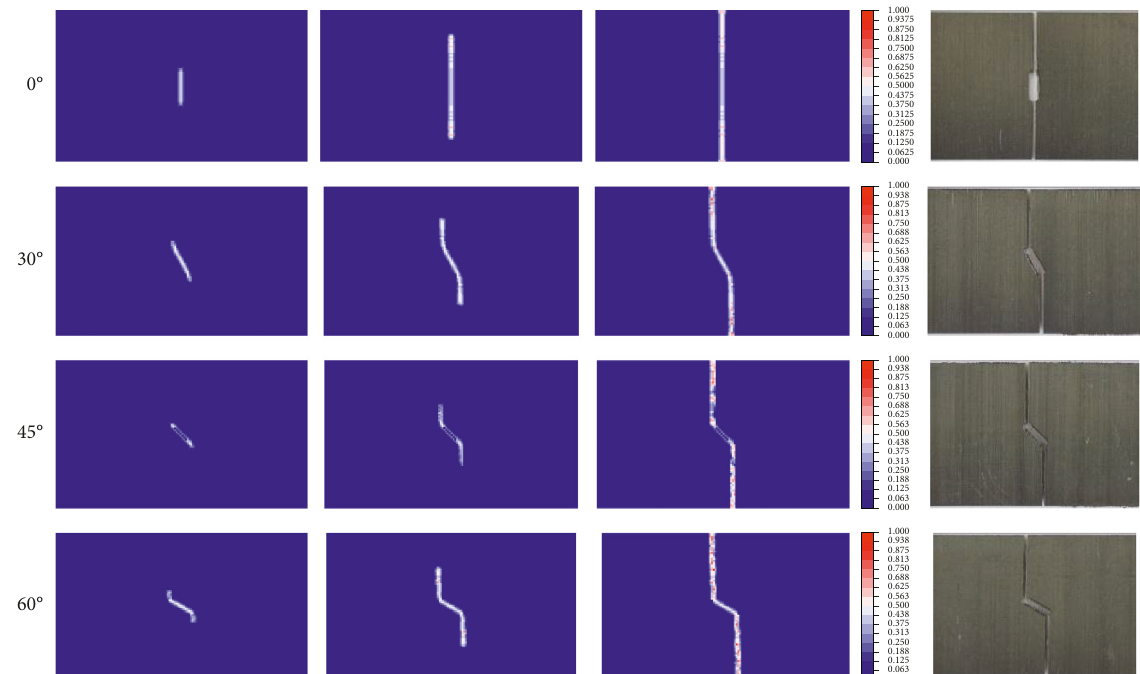
Figure 20: Crack propagation of UD reinforced lamina under mixed-mode loading (damage (0-1)).